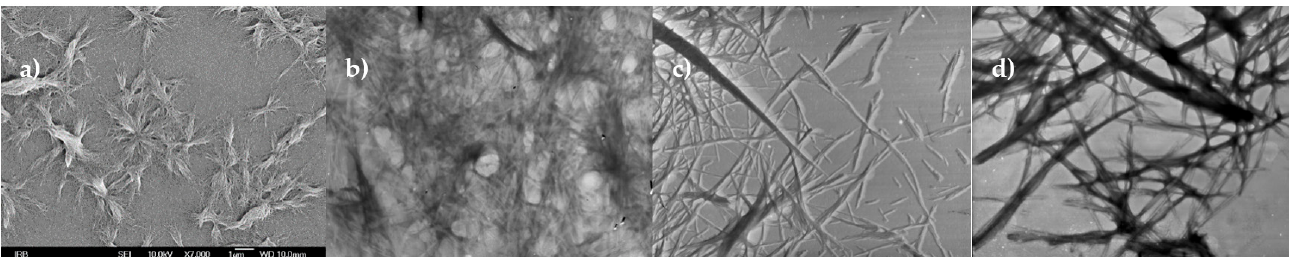
Figure 9. ( a ) SEM micrograph of freshly prepared 1a /DMF-H 2 O gel ( b ) micrograph of 1a /DMF-H 2 O